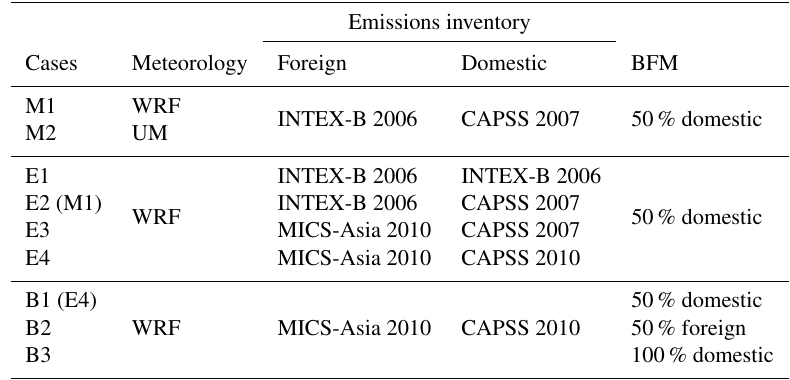
Table 1. Modeling configurations for meteorology and emissions inventories.